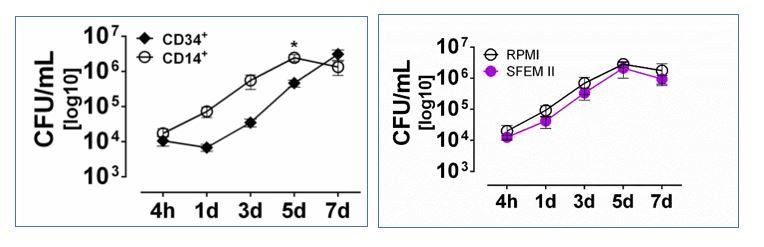
Comparative Mtb growth in purified CD14+ vs CD34+ cells.Left panel, Mtb growth curve in sorted purified CD34+ or CD14+ cell cultures. Right panel, Mtb growth curve of sorted purified CD14+ cells cultivated in RPMI vs StemSpan SFEM II media.